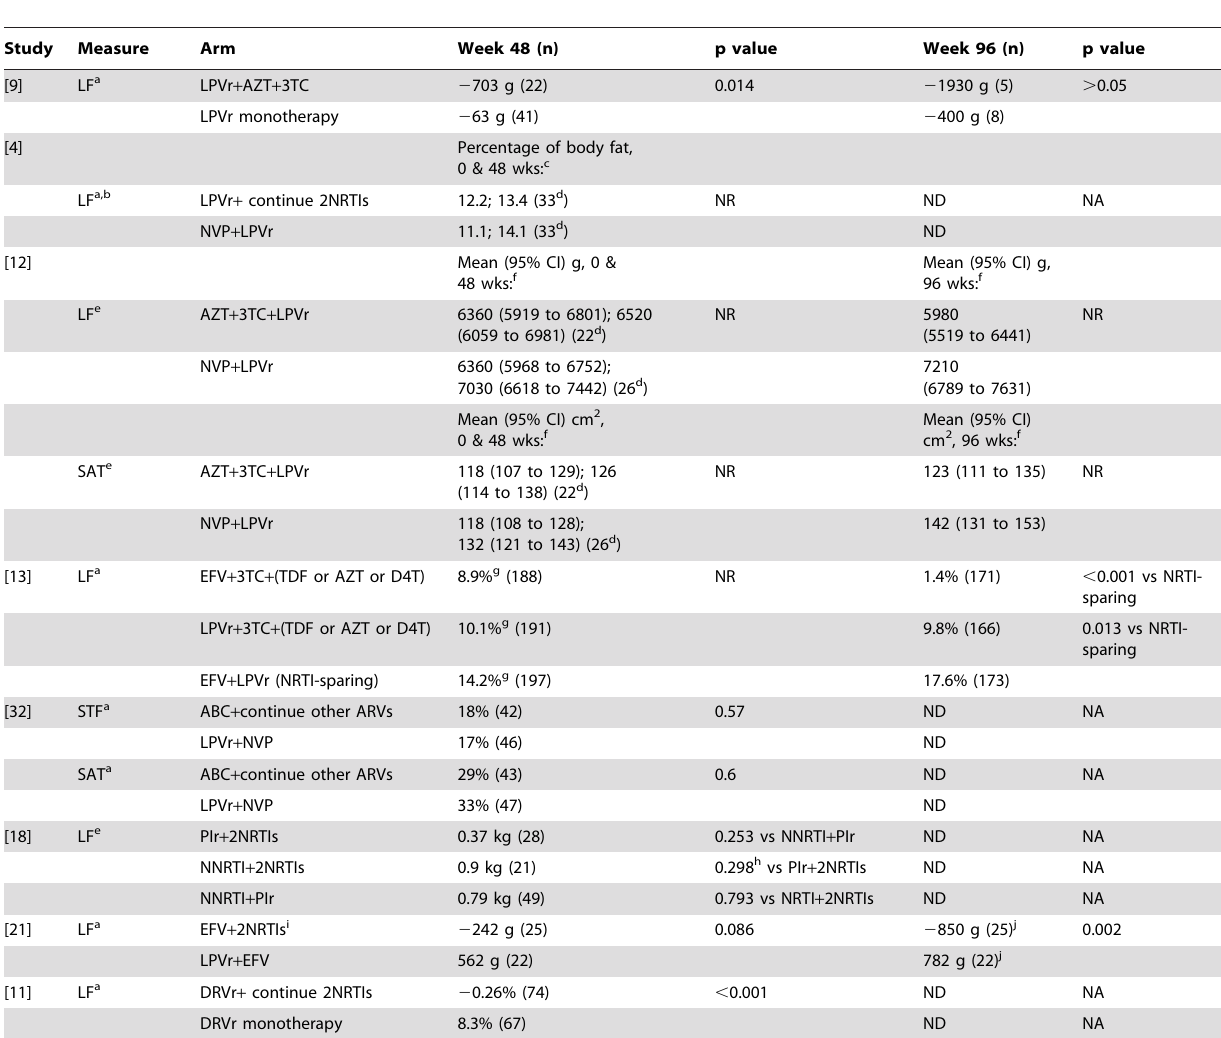
Table 2. Change from baseline in limb fat (LF) on DEXA scan, and subcutaneous thigh fat (STF) and subcutaneous adipose tissue (SAT) on CT scan: NRTI-containing regimens versus NRTI-sparing